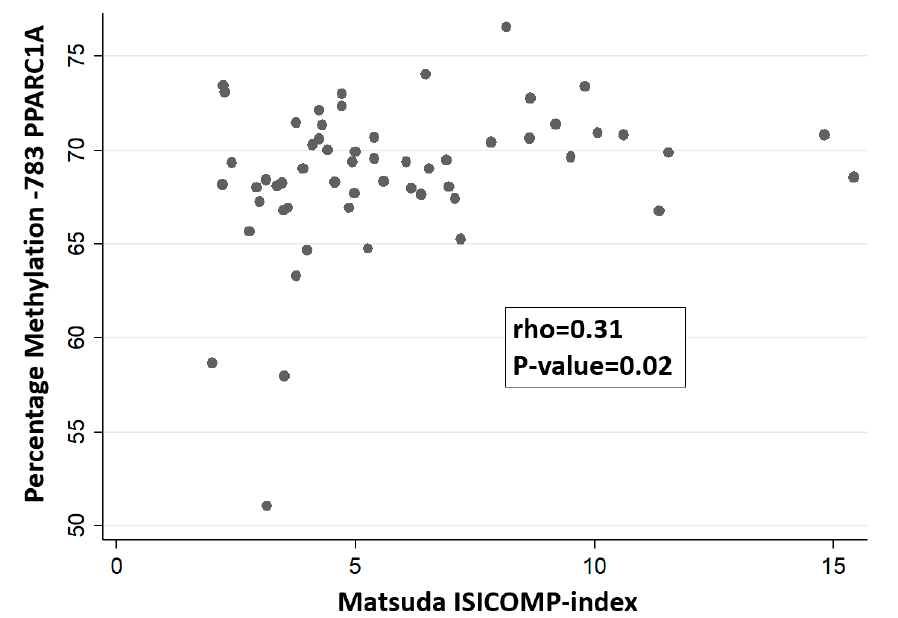
Figure 3. Association between the methylation levels in the -783 CpG position of the PPARGC1A gene in leukocytes with the Matsuda composite index.